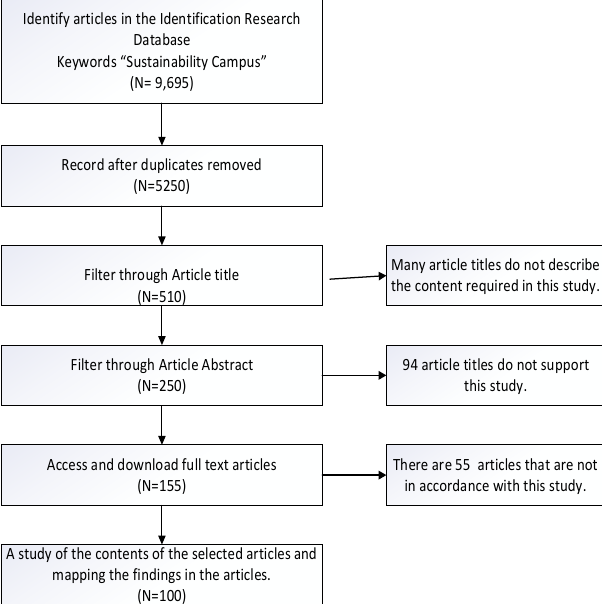
Figure 2. Searching strategy and study selection process.